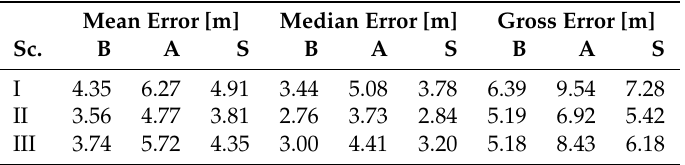
Table 2. Comparison of localisation errors before (B) and after (A) the RSS change as well as when the localisation model was rebuilt by our system